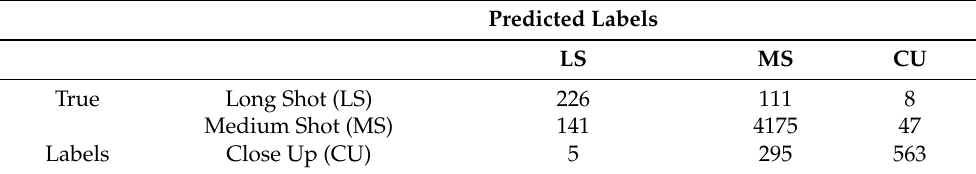
Table 23. Confusion Matrix of our methodology on a subset of the Cinescale dataset. Predicted Labels LS MS CU True Long Shot (LS) 226 111 8 Medium Shot (MS) 141 4175